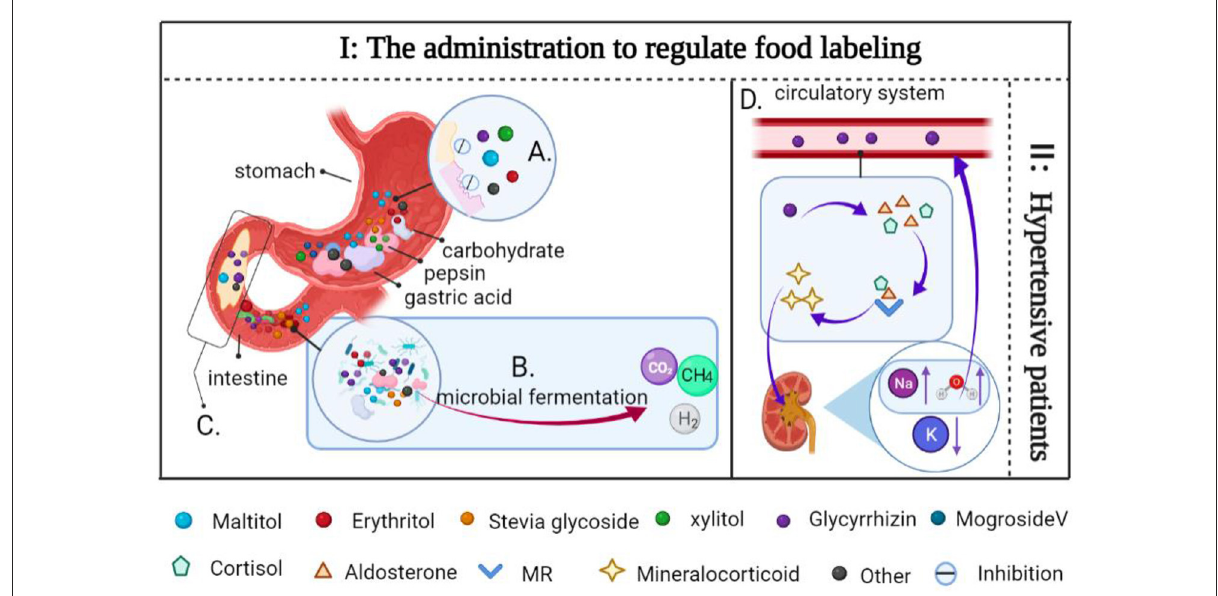
FIGURE12 Side effects of some NSS and solutions. (A) Sugar alcohols are difficult for pepsin and gastric acid to digest. (B) Sugar alcohols and some carbohydrates are fermented together in the gut by microbes to produce gases (CO 2 , H 2 , and CH 4 ). (C) Sugar alcohol sweeteners enter the intestine rapidly due to their inability to be digested, increased transport into the small intestine may lead to increased permeability in the lumen of the small intestine, resulting in water retention. (D) Glycyrrhizin inhibits the 11 β -hydroxy steroid dehydrogenase activity, preventing cortisol from being converted to corticosterone, and it also increases the level of aldosterone in the human body when combined with cortisol, aldosterone, and MR, resulting in mineralocorticoid excess, increases the level of water and sodium ions in the blood, resulting in water sodium retention. As a consequence, increased blood volume results in hypertension and hypokalemia. (I) The administration to regulate food labeling to indicate the recommended intake range of NSS and the consumption group. (II) Contraindicated in patients with